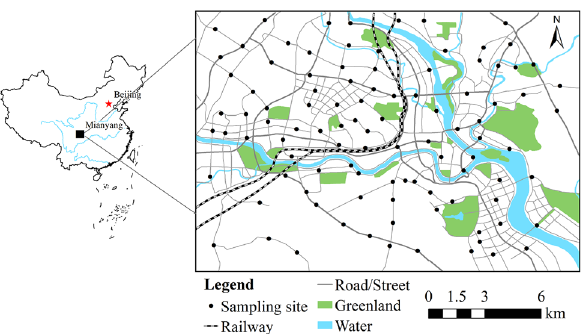
Figure 1. Research region and sampling locations in Miangyang, China [the figure was generated by Huaming Du using the ArcGIS 10.3 (https:// devel opers. arcgis.